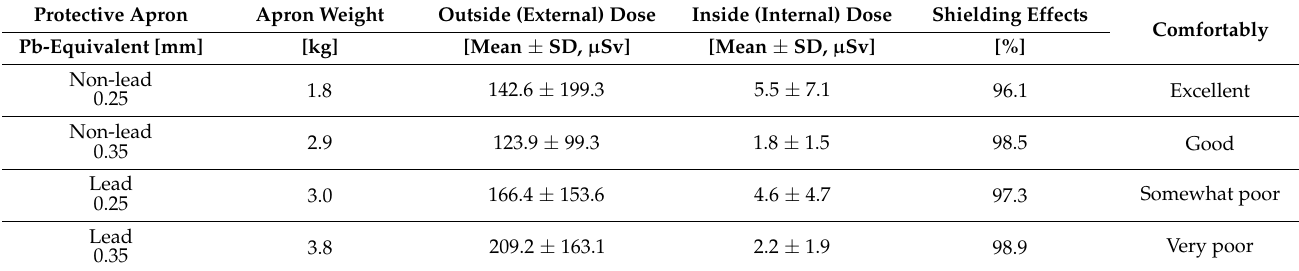
Table 2. Summary of our study on the performance of protective aprons in the clinical setting. Each was used for more than 50 catheterizations, including